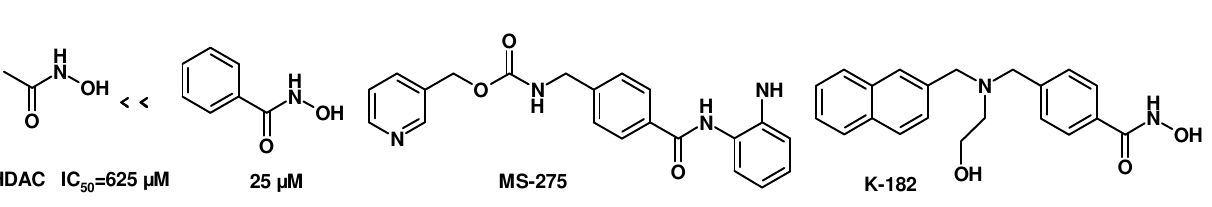
Figure 4. Structures of HDAC